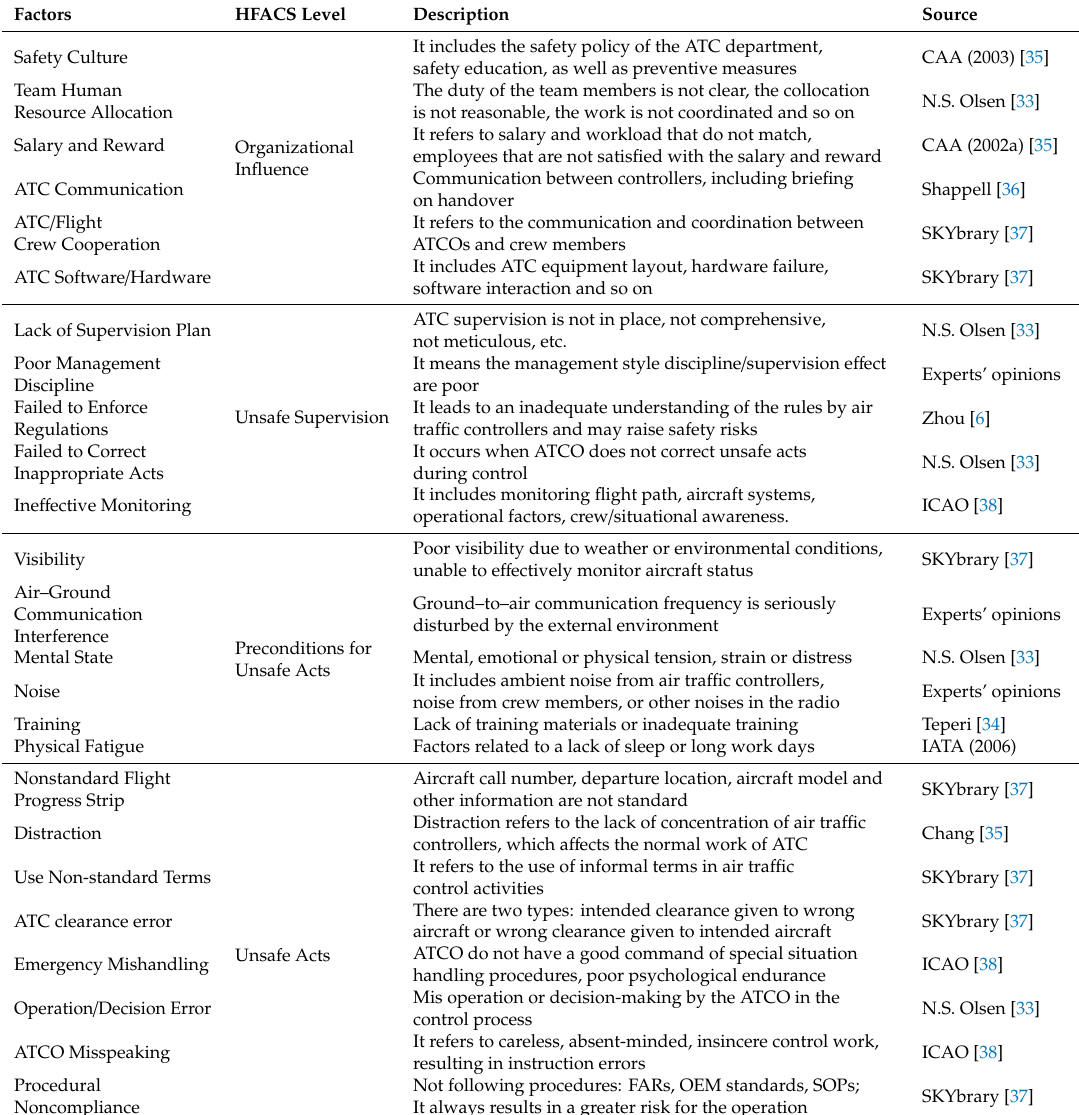
Table 1. Factors description and its